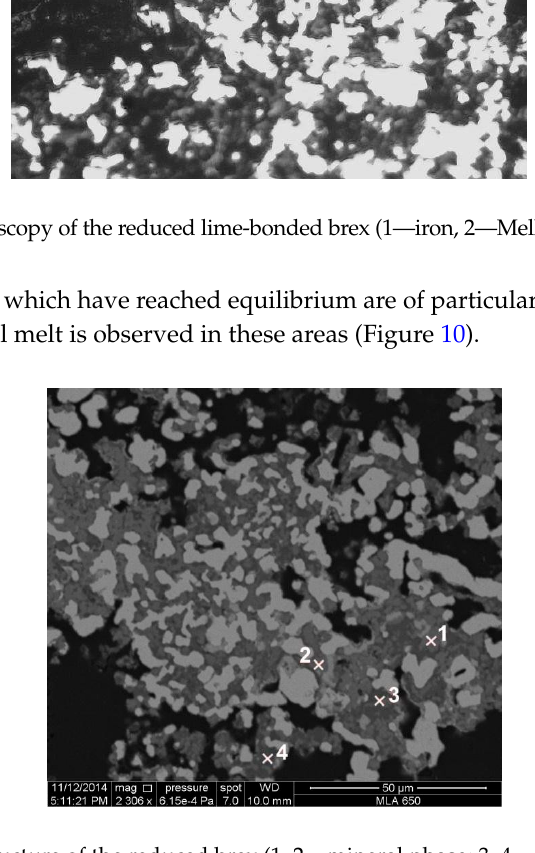
Figure 10. Structure of the reduced brex (1, 2—mineral phase; 3, 4—residual melt).